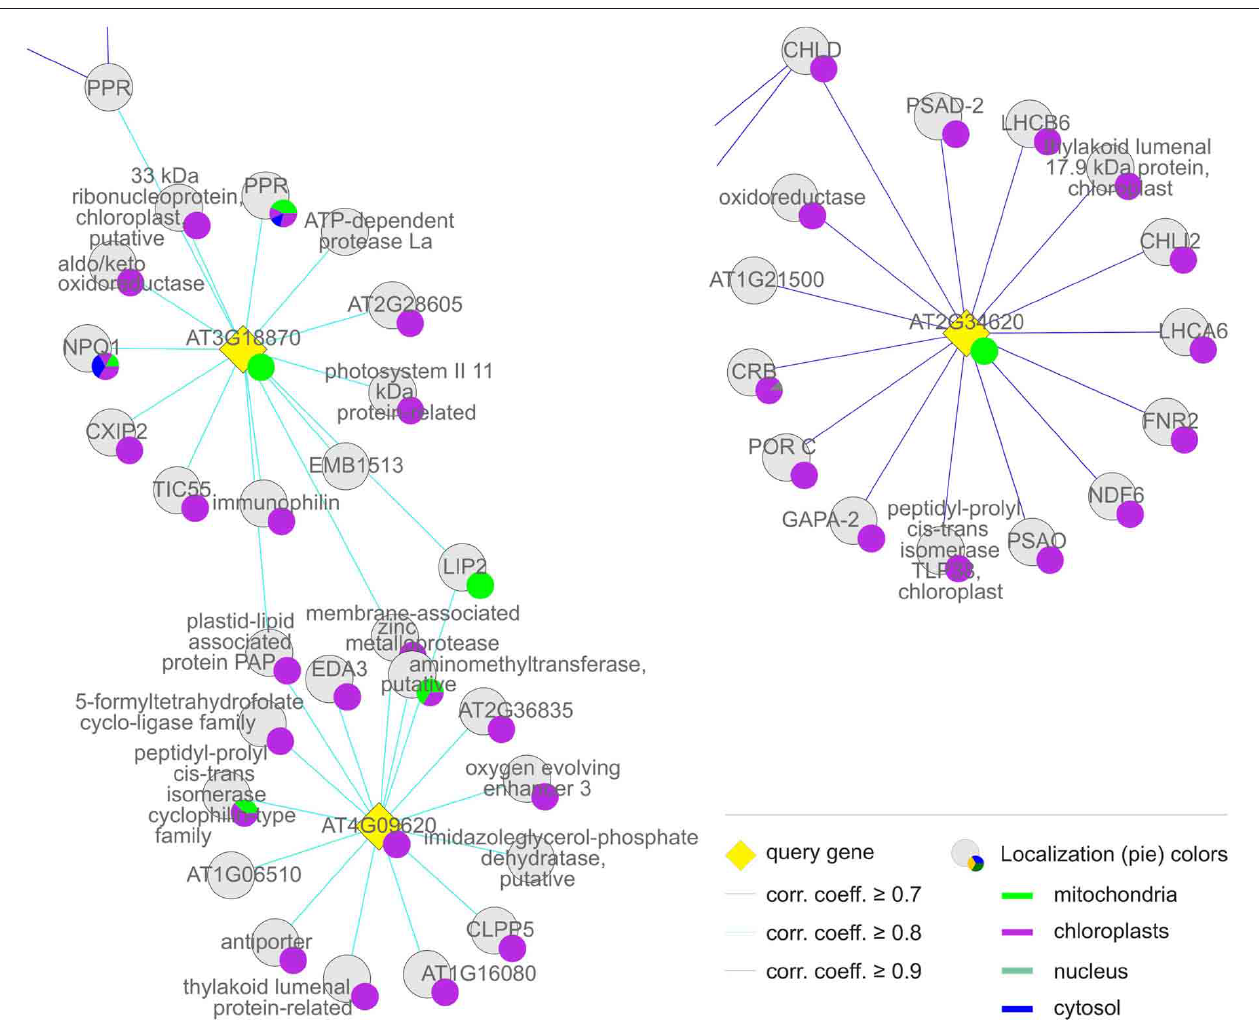
FIGURE 5 | Group (ii), the “chloroplast-associated” cluster. The coregulation network was generated as in Figure 4 .